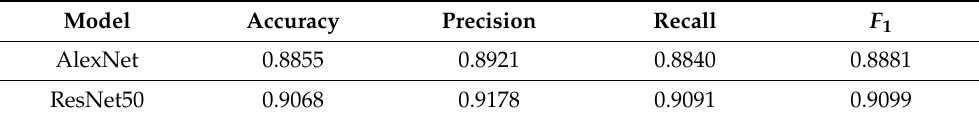
Table 2. NDT-Multiresolution Analysis: Comparison of two model’s crack detection results. Model Accuracy Precision Recall